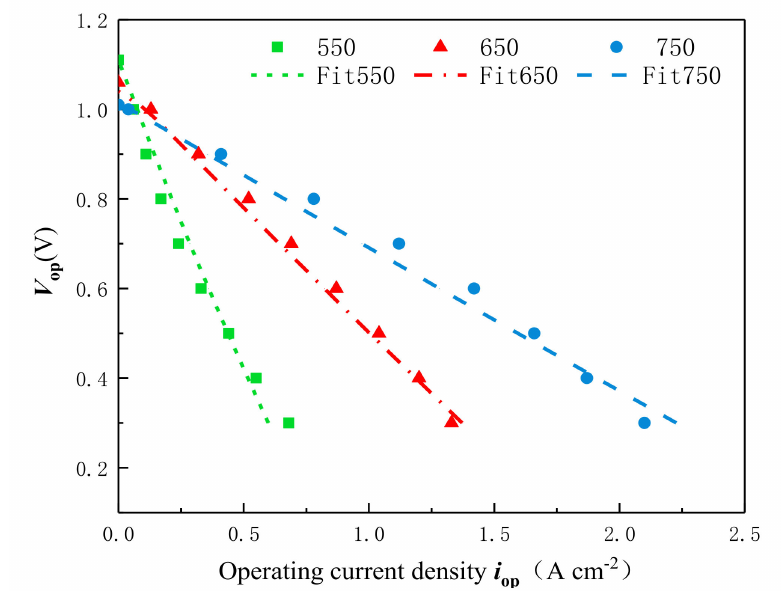
Figure 2. Comparison of the i op -V op curves between the calculated and experimental results at various